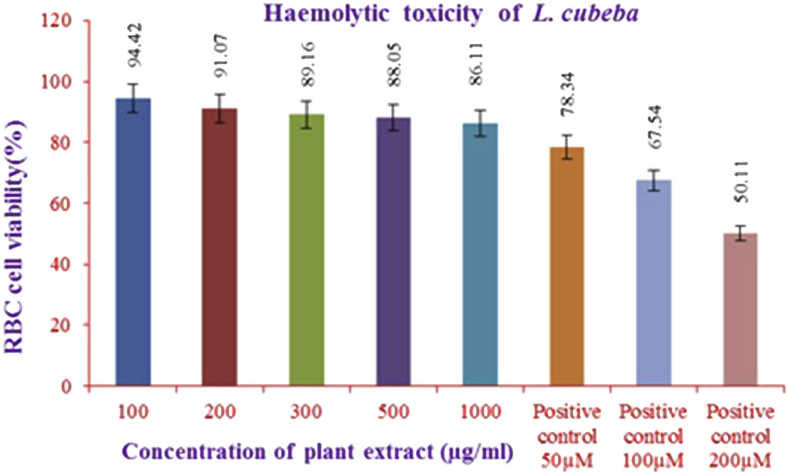
Haemolytic toxicity of L. cubeba and H2O2 (positive control).